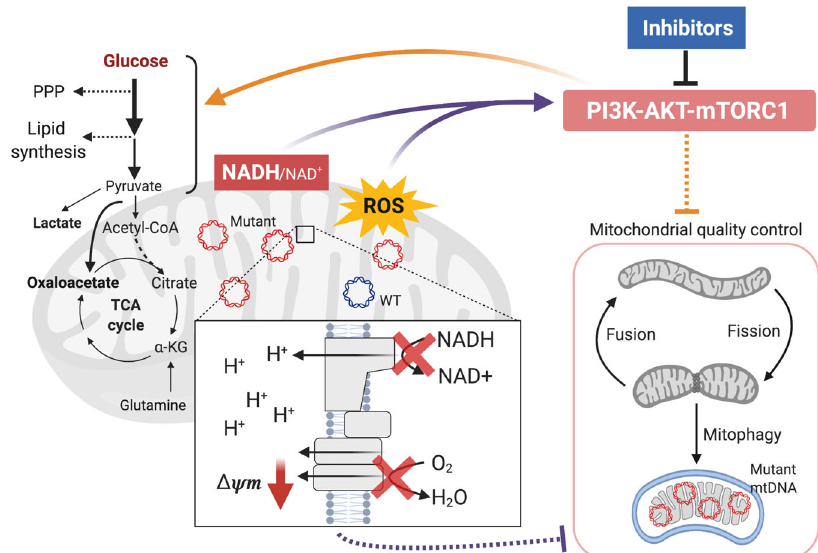
Fig. 7 Inhibition of the PI3K-Akt-mTORC1 axis reduces the m.3243 A > G mutant load. A scheme describing how the m.3243A > G mutation alters cell metabolism, including mitochondrial dysfunction, altered glucose metabolism, redox imbalance and oxidative stress, which may lead to the constitutive activation of the PI3K-Akt-mTORC1 pathway. Pharmacological inhibition of this pathway reduces mutant load, partially rescues mitochondrial function and reduces glucose dependence in a cell-autonomous way. Although the underlying mechanisms for selecting against the mutant mtDNA need further investigations, these fi ndings suggest that the activation of the PI3K-Akt-mTORC1 pathway drives a positive feedback cycle, which maintains/increases mutant mtDNA, augments the metabolic rewiring and thus exacerbates the perturbation of cell signalling. This positive feedback loop may shape the phenotype of the disease and determine disease progression. The scheme was created using